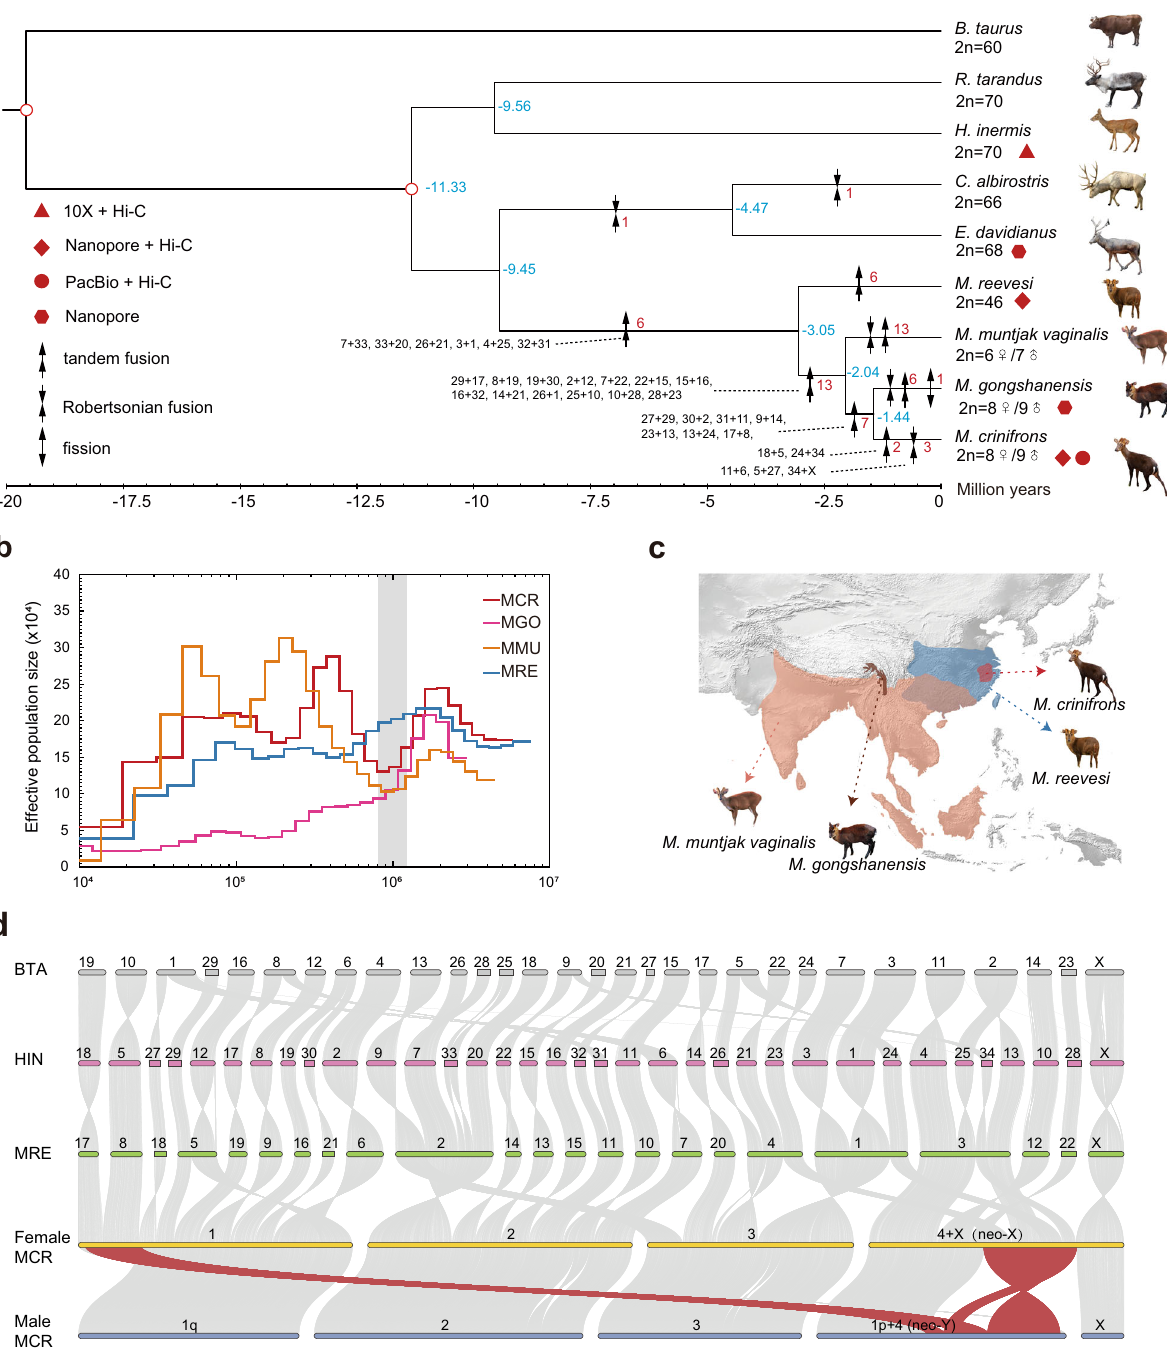
Fig. 1 Phylogeny, demographic histories, and distribution and chromosome synteny of muntjac species. a Maximum likelihood tree of muntjac and outgroup species with the respective sequencing technologies (red geometries), the divergence time (blue numbers) and number of chromosome fusion or fi ssion events (red numbers) shown. Different combinations of black arrows represent different types of chromosome fusion and fi ssion. The 31 fusion events leading to M. crinifrons are displayed in detail with the chromosome code (black numbers) of H. inermis , which are connected with the arrow mark on the phylogenic tree with dotted lines. Red hollow circles mark the nodes whose divergence times were used as calibration for estimating the divergence time among other species. b The demographic histories of M. reevesi (MRE), M. muntjak vaginalis (MMU), M. gongshanensis (MGO), and M. crinifrons (MCR) estimated by PSMC 37 . The gray box marks the time range of the Xixiabangma Glaciation (XG, 0.8-1.17 million years ago). c Topographic map on current geographic distribution of the four muntjac species. The colors of dashed line are consistent with the colors of distribution areas of a particular species. d The chromosome synteny between B. taurus , H. inermis , M. reevesi , female and male M. crinifrons with chromosome names shown above. 1p and 1q represent short arm and long arm of chromosome 1, respectively. The red line indicates the synteny blocks of female and male M. crinifrons in neo-Y inverted